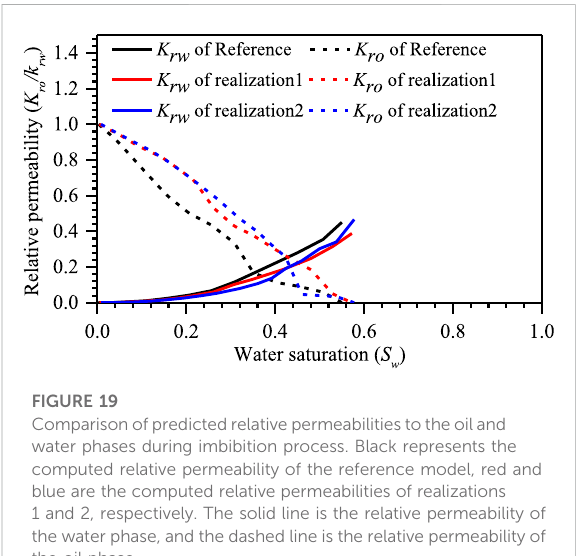
FIGURE 19 Comparison ofpredictedrelativepermeabilitiestotheoiland water phases during imbibition process. Black represents the computed relative permeability of the reference model, red and blue are the computed relative permeabilities of realizations 1 and 2, respectively. The solid line is the relative permeability of the water phase, and the dashed line is the relative permeability of the oil